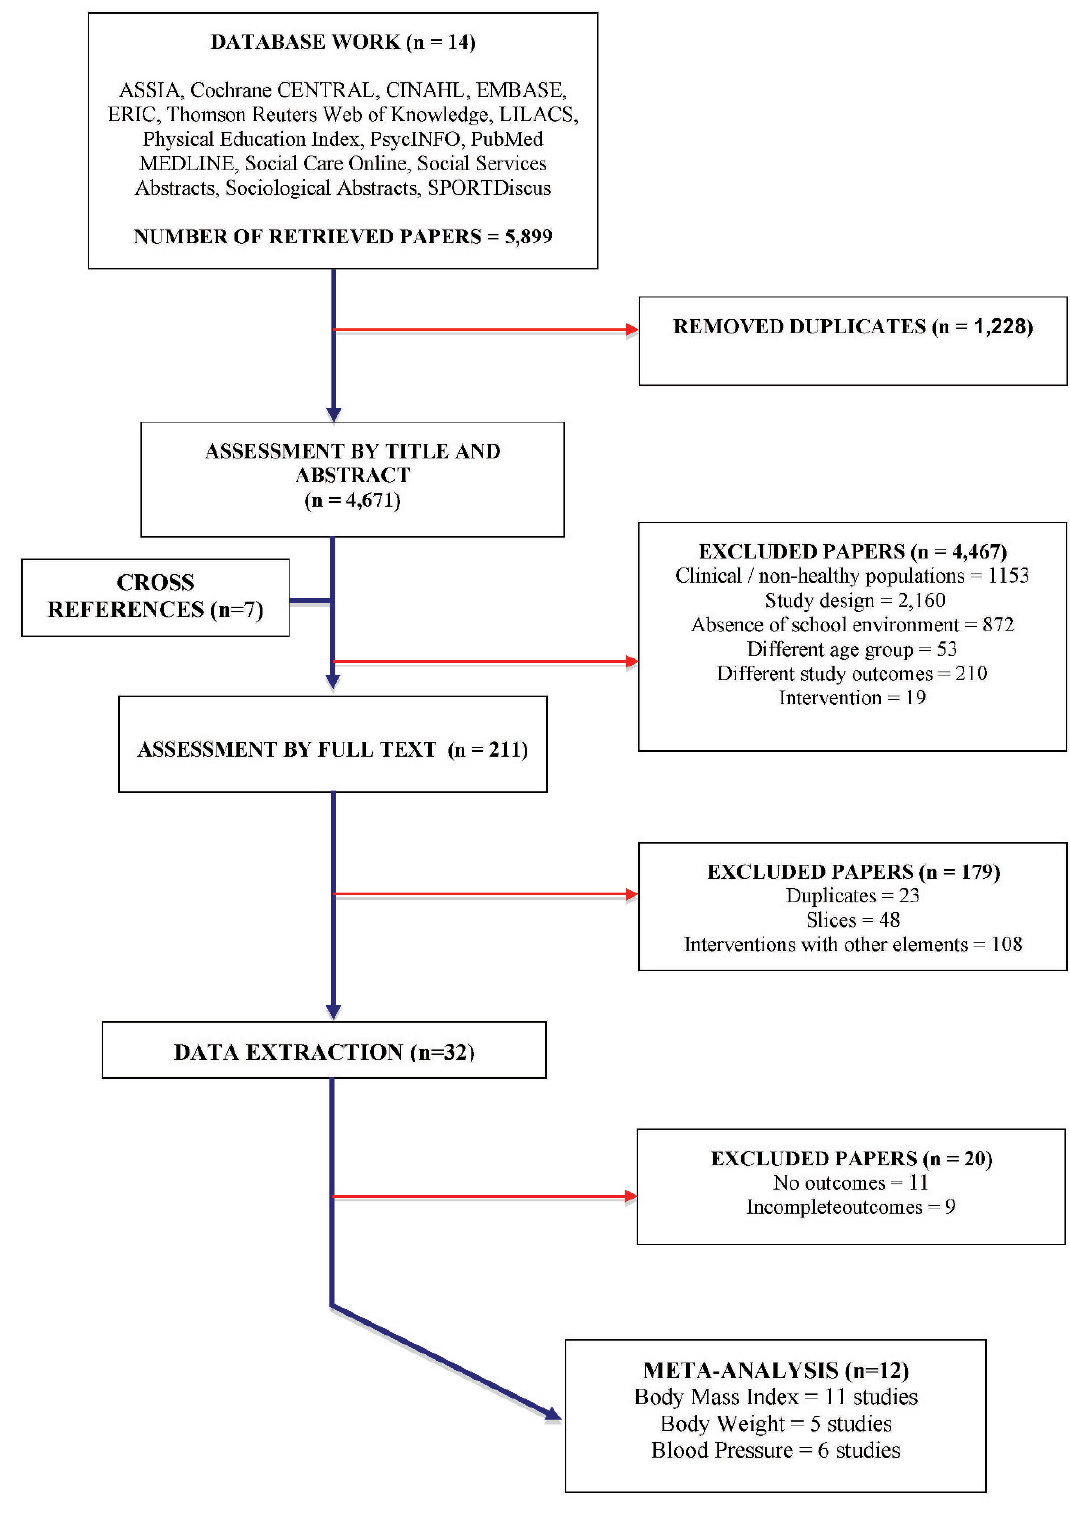
Figure 1 - Meta-analysis flow